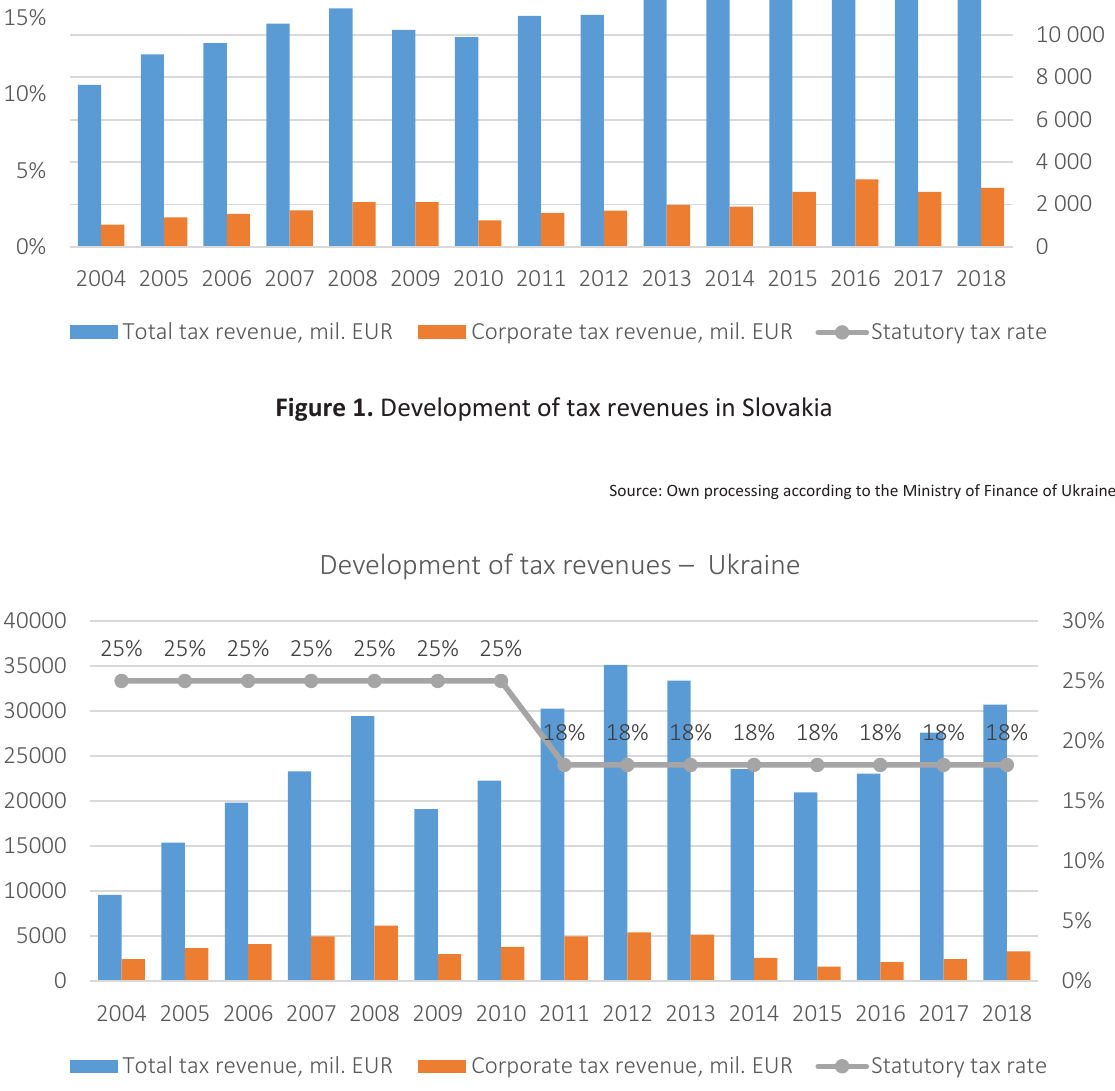
Figure 2. Development of tax revenues in